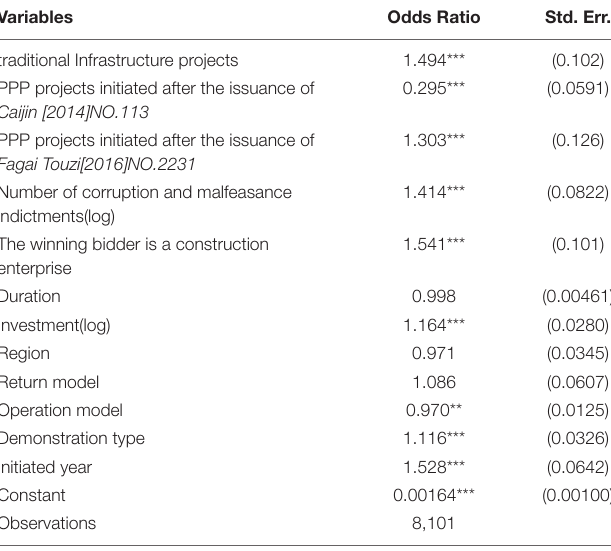
TABLE 5 | Quantile regression result. TABLE 6 | Regression result of substitute proxy